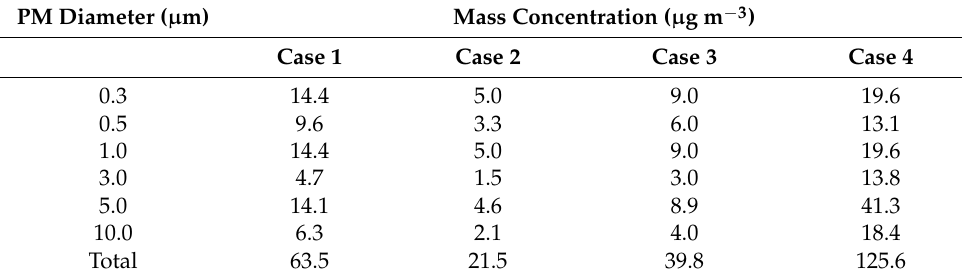
Table 2. Size-resolved outdoor PM mass